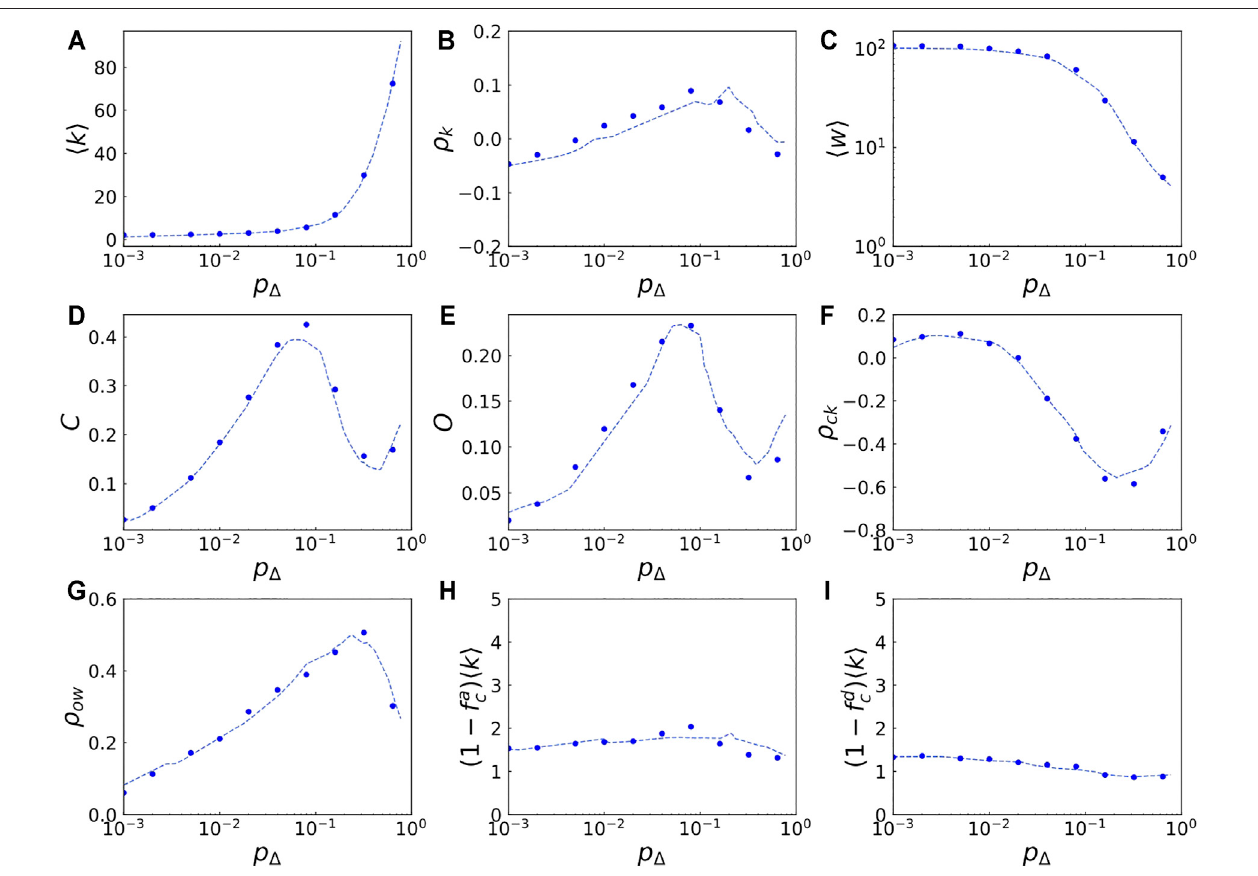
FIGURE 3 | Comparison between the predictions by machine learning and the simulations. Each panel shows how each network property of the generated networks changes with respect to the value of the parameter for the triadic closure, p Δ . In each panel the dashed curveshows the predictions by machine learning while the fi lled circles indicate the simulation results averaged over fi ve independent runs, showing that the machine learning predicts the model outputs quite well. Other parameter values are fi xed at N (cid:1) 2,000, F (cid:1) 2, q (cid:1) 2, α (cid:1) 0, p r (cid:1) 0.001, w r (cid:1) 1, p nd (cid:1) 0.001, p ld (cid:1) 0.01, A (cid:1) 0.003, and t (cid:1)